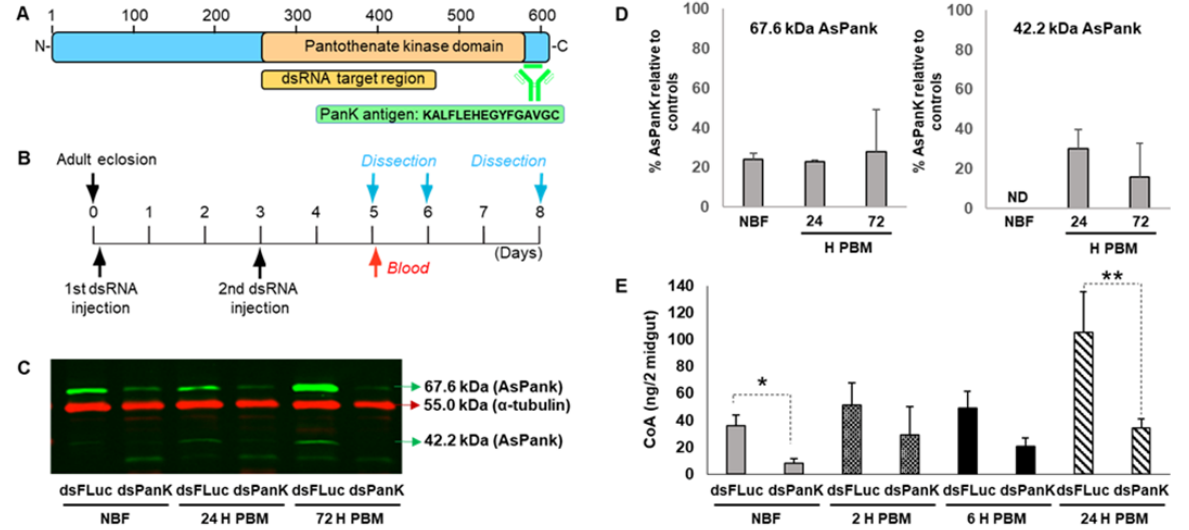
Figure 2. A. stephensi PanK RNAi reduced midgut PanK protein and coenzyme A (CoA) levels. ( A ). Schematic of A. stephensi PanK indicating the target location of the dsRNA construct and the peptide sequence used to generate the custom polyclonal antibody. ( B ). Experimental design for RNAi assays. A. stephensi females were injected with dsRNA targeting A. stephensi ( dsPanK ) or firefly luciferase (dsFLuc) within 4 h after adult eclosion and again at 3 d post-emergence. Mosquitoes were provided human blood on day 5 and midguts were dissected prior to blood feeding (non-blood-fed, NBF) and at 24 h and 72 h post-blood meal (PBM). ( C ). Representative immunoblot showing putative A. stephensi PanK isoforms (67.6 kDa and 42.2 kDa; green bands) following PanK RNAi relative to FLuc RNAi control (red band). Each lane represents one midgut equivalent from pools of ten mosquito midguts. RNAi and immunoblots were replicated twice with distinct cohorts of mosquitoes. ( D ). Densitometry analysis of the 67.6 kDa and 42.2 kDa A. stephensi PanK isoforms. Bars represent mean and standard deviation of percent PanK protein expression in mosquitoes inoculated with dsPanK relative to mos- quitoes injected with dsFLuc. ( E ). Midgut CoA levels in dsPanK- and dsFLuc-treated A. stephensi . Differences between treatment groups for respective timepoints were evaluated using Student’s t-test. ** p < 0.01 and * p < 0.05. Experiments were replicated three times with independent cohorts of mosquitoes. 3.3. PanK Small Molecules Predictably Altered A. stephensi Midgut CoA Levels While RNAi enabled us to confirm that A. stephensi PanK is functionally associated with midgut CoA levels, we sought to identify PanK-modulating small molecules that might ultimately be deployable to mosquitoes via attractive bait stations. To this end, we selected PZ-2891 and compound 7, which have been described as activating (EC 50 of 1.3 nM for human PanK3 [17]) and inhibiting (mean EC 50 of 62 nM for human PanK3, PanK1 β and PanK2 [23]) human PanK catalytic activity, respectively, to test our hypothesis that activation of A. stephensi PanK would be associated with increased midgut CoA levels, while inhibition would be associated with reduced midgut CoA levels. The 3D structure of PZ-2891 has been published [17] and through homology model- ing we compared the catalytic core of A. stephensi PanK (Uniprot: A0A182YPP9) to human PanK1 (Uniprot: Q8TE04-2), PanK2 (Uniprot: Q9BZ23), and PanK3 (Uniprot: Q9H999). A. stephensi PanK is 80% similar and 65% identical to human PanK3 and the conserved sig- nature sequences [6]: xDIGGTLxKLxY, TGGGAxKF, VNxGSGVS, LGGGTFxGLCxLLT, DKLVxDIYGG, and GLxGxxVASSFG are present. The key catalytic residues Glu28 and Arg193 are essential for PanK function and distinguish bona fide PanKs from pseudo- PanKs (Supplementary Figure S1) [28]. This high sequence similarity supported the use of the PanK3 structure as a template for homology modeling. We used the coordinates of PanK3•ATP•Mg 2+ •PZ-2891 [17] to predict how A. stephensi PanK interacts with PZ-2891. The mosquito PanK has the identical residues that stabilize the allosteric dimer interface and interact with ATP, pantothenate, and acetyl-CoA in PanK3 (Figure 3) [29,30]. Residues surrounding the PZ-2891 molecule show the isopropyl moiety packs into a hydrophobic cavity of the pantothenate binding site, the carbonyl group hydrogen bonds to catalytic